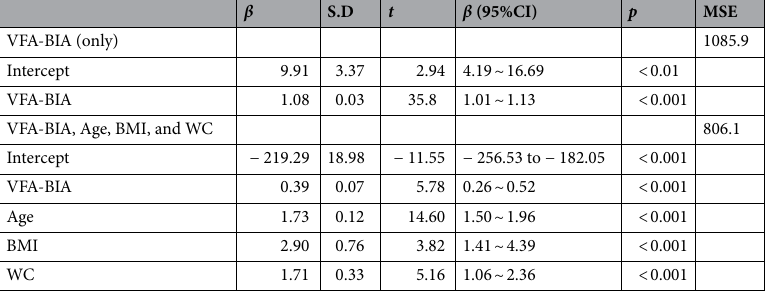
Table 6. The Multivariate regression models estimate the VFA in females between BIA and QCT.